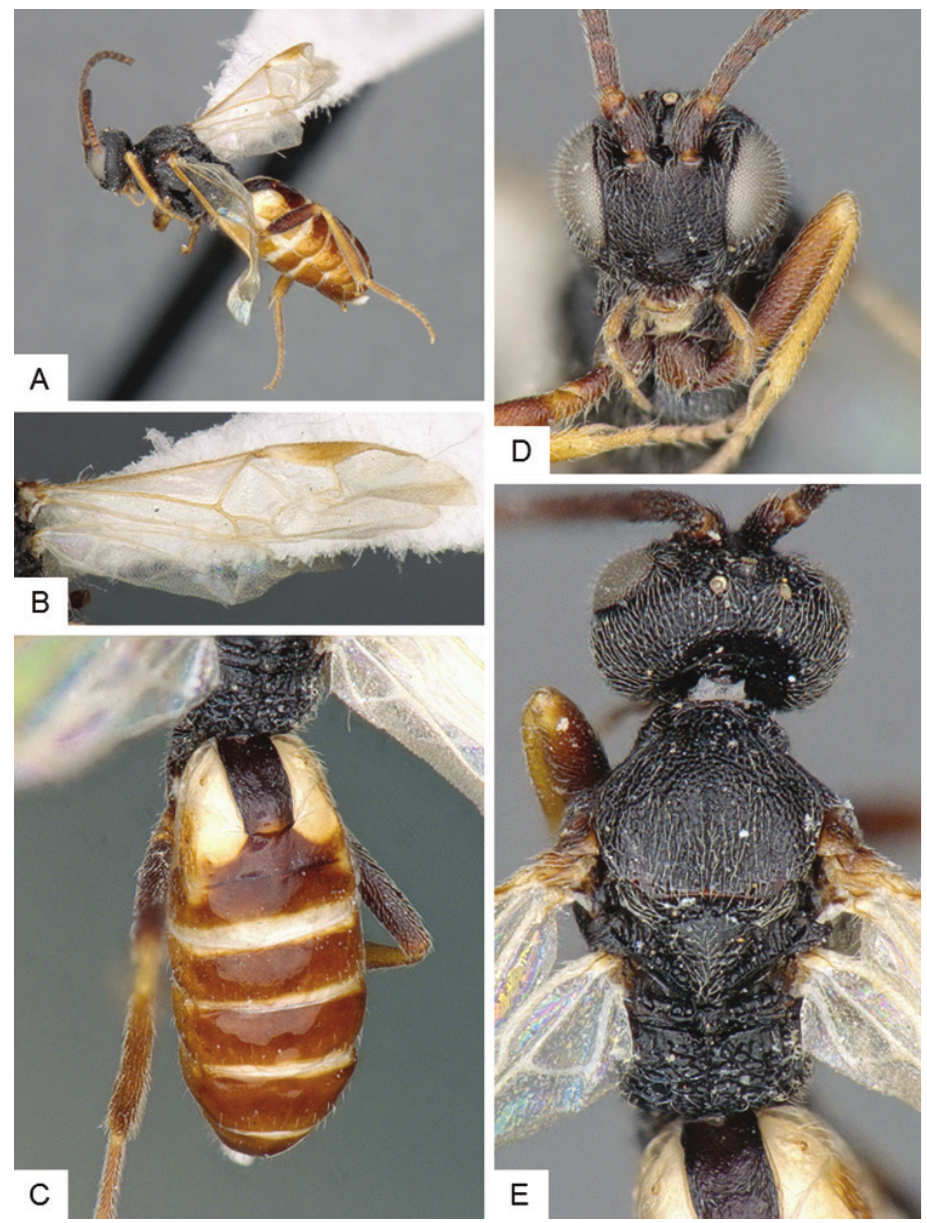
Figure 27. Microplitis coactus . A Habitus, lateral B Fore wing C Metasoma, dorsal D Head, frontal E Head and mesosoma,